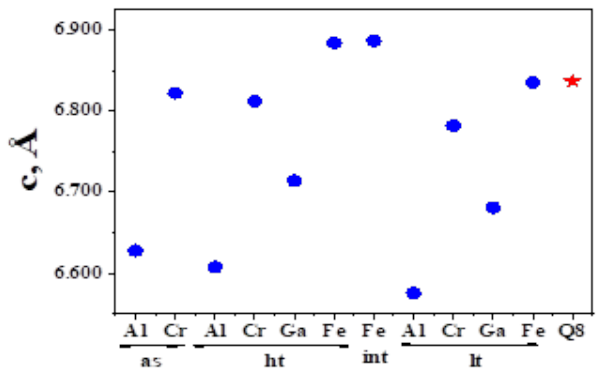
Figure 8. Unit cell parameter c, Å of phases I—VI (Table 1). The star symbol denotes the MIL-53(Fe) sample (Q8) obtained.